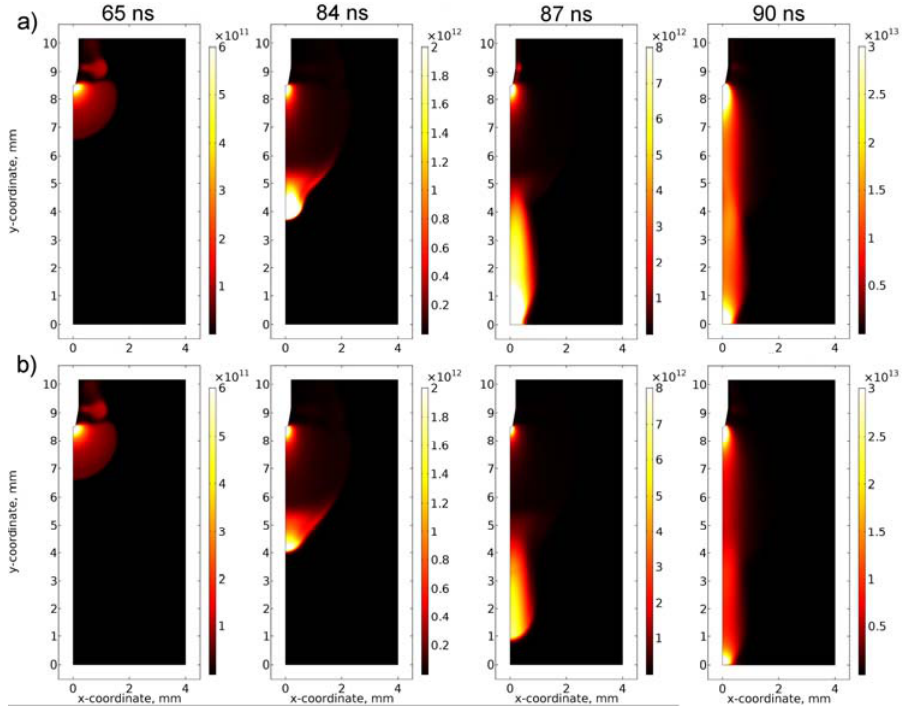
Figure 5 – Spatial distribution of the electron number density (scale in cm -3 ) for gas discharge a) without and b) with the photo-ionization process for the same time points Рис . 5 – Пространственные распределения концентрации электронов (